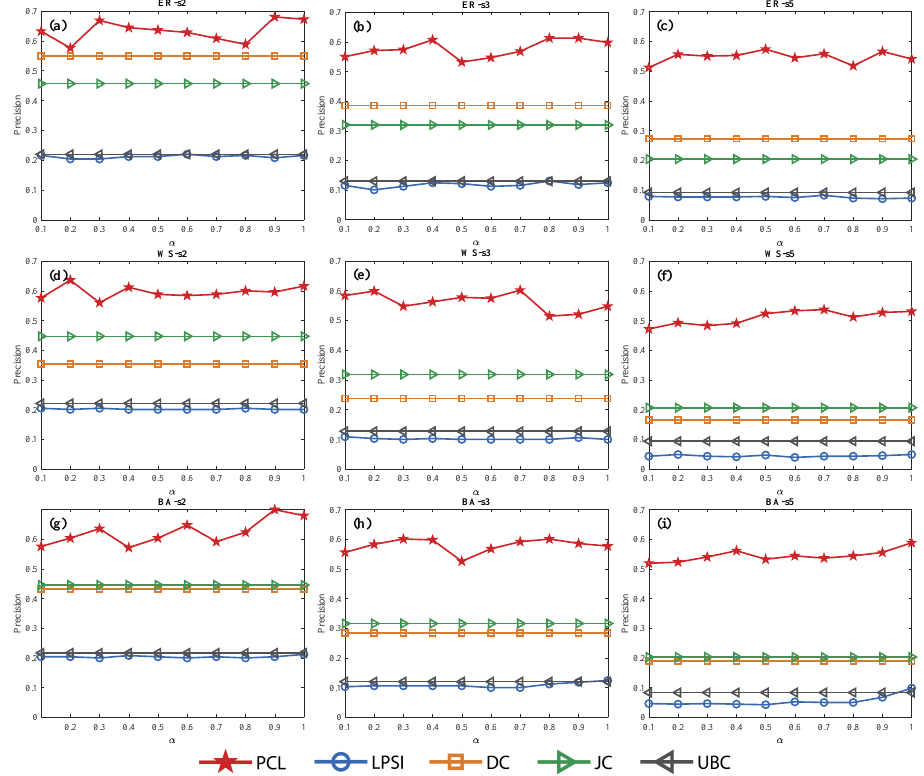
Figure 4. Sources localization accuracy of different numbers of sources with five methods in synthetic networks. ( a – c ) The relationship between precision and α ( β = − 1) for different number of sources in ER network. The number of sources is s = 2,3,5 respectively, which is similar to Figure 5. The scale of the network is N = 100 and the average degree is < k > = 4. ( d – f ) The difference is that